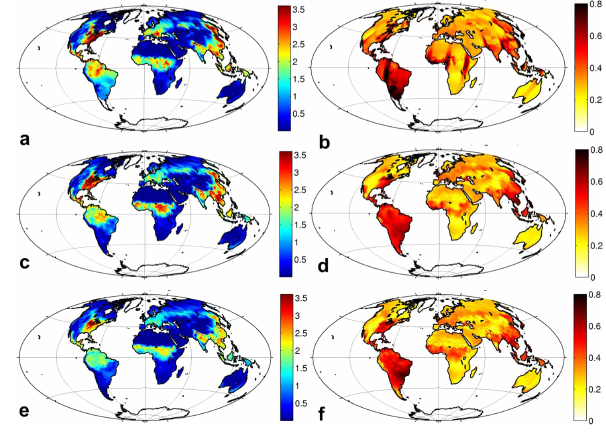
Figure 5. Maps of global SIF (mWm − 2 sr − 1 nm − 1 ) (a, c, e) and associated estimation uncertainties expressed as standard deviations (b, d, f) , for 1 August 2009 (a, b) , 2–7 August 2009 (c, d) and 1–31 August 2009 (e, f) obtained using GOME-2 observations and the presented mapping approach at 1 ◦ × 1 ◦ spatial